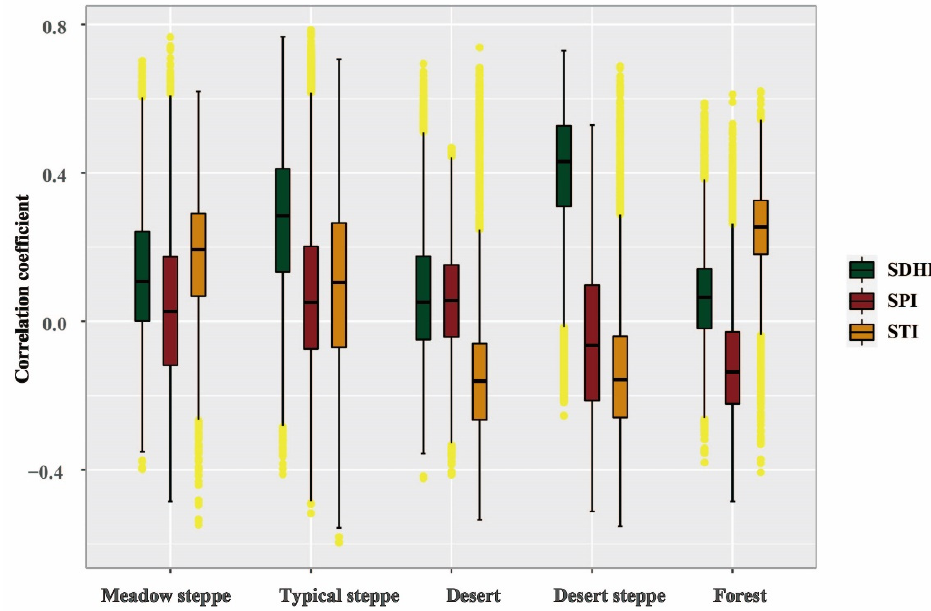
Figure 10. Box plot of the correlation between different vegetation types and SPI, STI, and SDHI in Inner Mongolia.